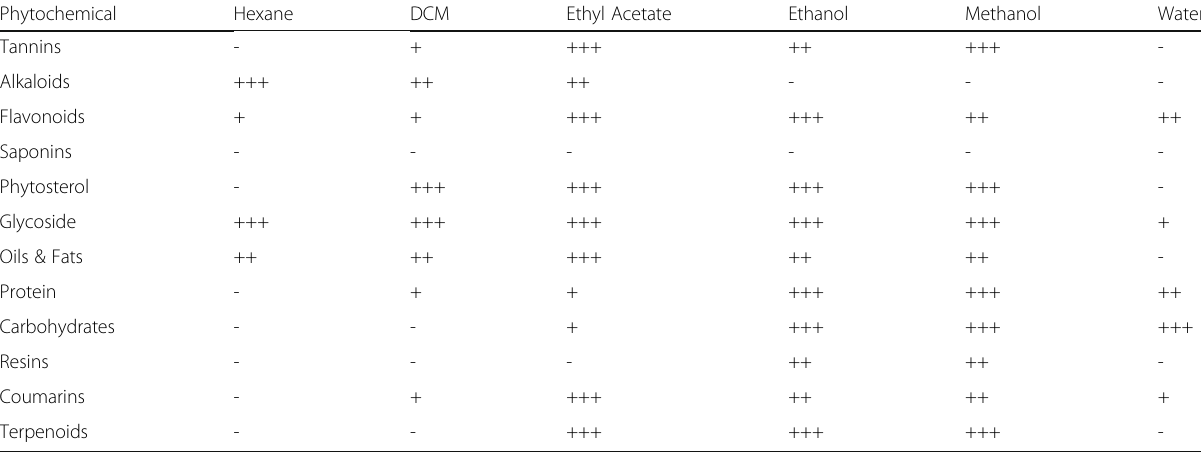
Table 1 Phytochemical analysis of G.acerosa